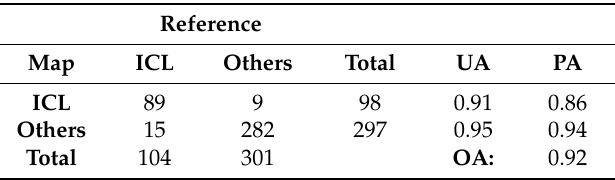
Table 7. Confusion matrices and accuracy statistics for integrated crop-livestock classification, validation on field data.